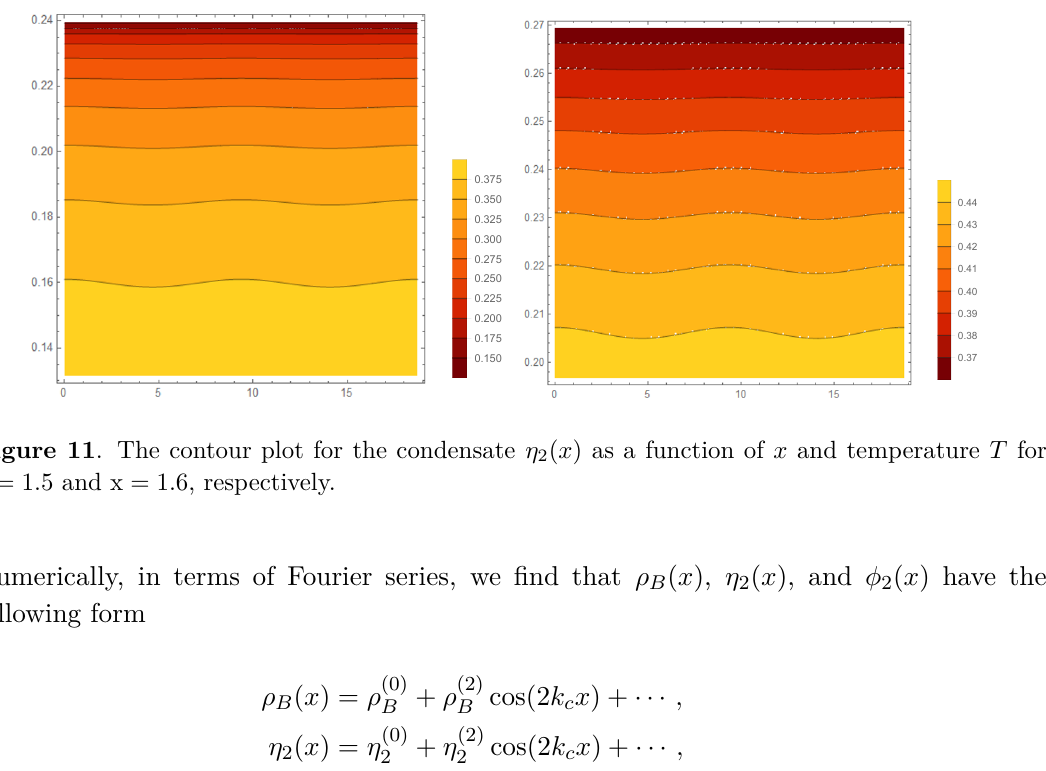
Figure 10 . The contour plot for the charge density wave ρ B ( x ) as a function of x and temperature T for x = 1 . 5 and x = 1 . 6 , respectively.